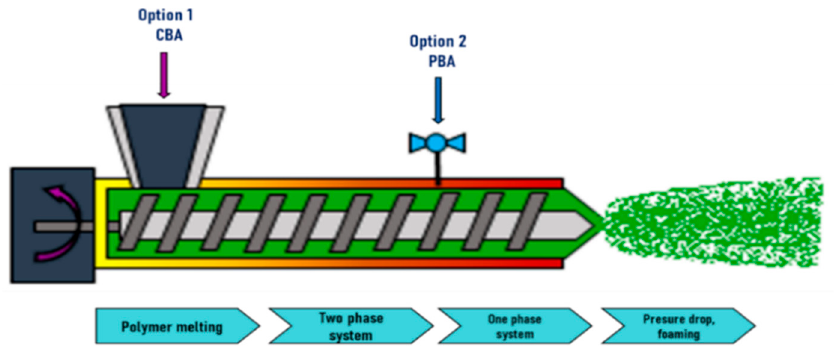
Figure 28. Principle of extrusion foaming. Adapted from Standau et al. [132].